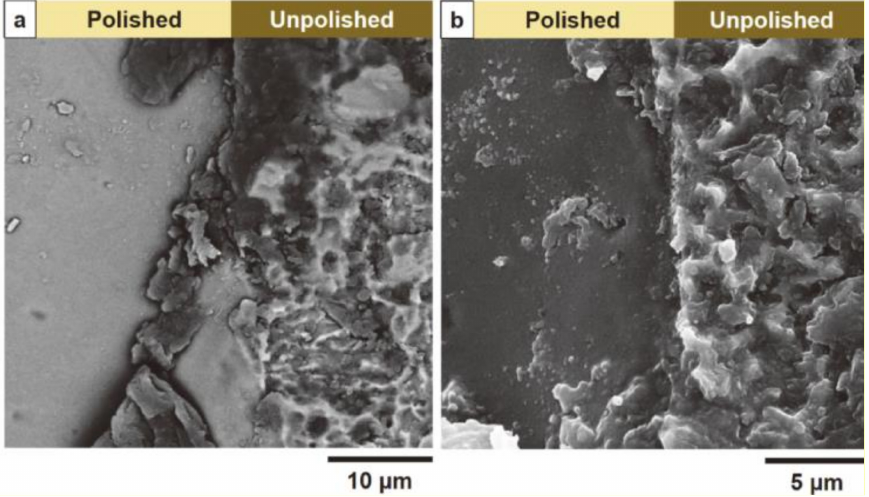
Figure 5. SEM images of the pure metallic Ti sample in ( a ) ChCl-MeOH- n -BuOH (1.2 V) and ( b ) ChCl-EtOH (2 V); 20 ◦ C, 40 min (reprinted with permission from ref. [43]; Copyright 2019 The Electrochemical Society of